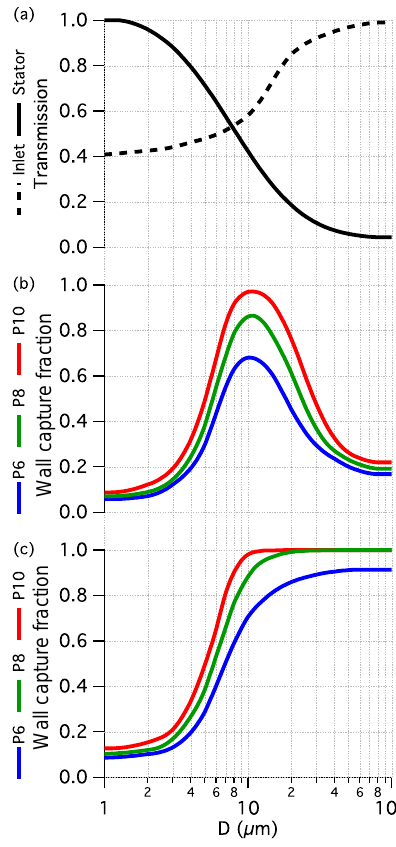
Figure 6. Statistics of trajectory ensembles across a range of droplet diameter. Panel (a) shows the transmission computed for the inlet and stator, which are unaffected by the pipe position. In panels (b) and (c) the fraction of droplets that migrate to the outer walls is compared between three pipe positions for (b) droplets at equilib- rium with the upstream flow and (c) droplets shed from the blade trailing edge with zero initial